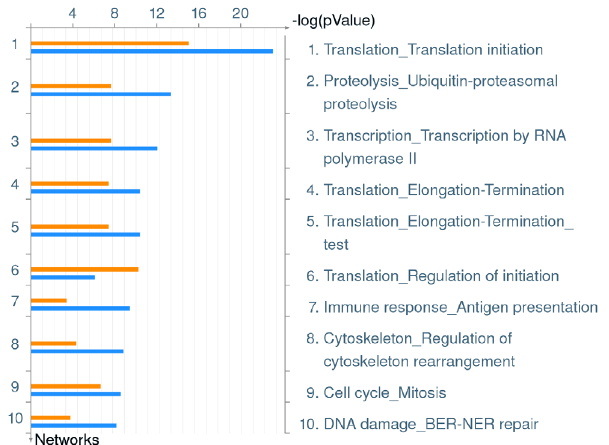
Figure 4. Top 10 Process Networks down-regulated in hMDMs upon infection by L. pneumophila . Metacore analysis of triplicate microarrays of wild type strain and ankB mutant-infected hMDMs 8 h post- infection showing the top 10 Process Networks. The upper orange bar of each column represents wild type- infected hMDMs while the lower blue bar represents the ankB mutant-infected hMDMs.